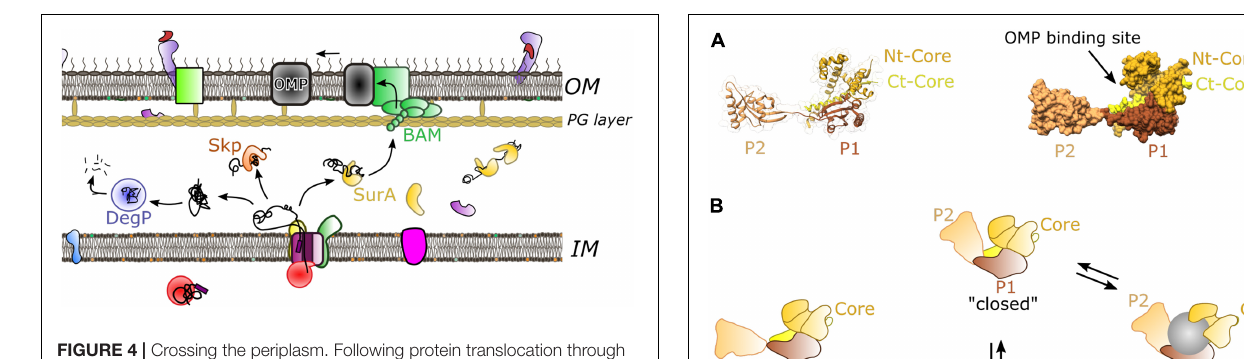
FIGURE 4 | Crossing the periplasm. Following protein translocation through the inner membrane multiple pathways operate during onward passage. The predominant chaperone SurA (yellow) holds the protein in an unfolded state prior to delivery to the outer-membrane through interaction with the BAM complex. Alternatively the chaperone Skp (orange) has aggregate recovery activity. If the peptide misfolds or aggregates DegP protease (blue) will degrade the substrate.